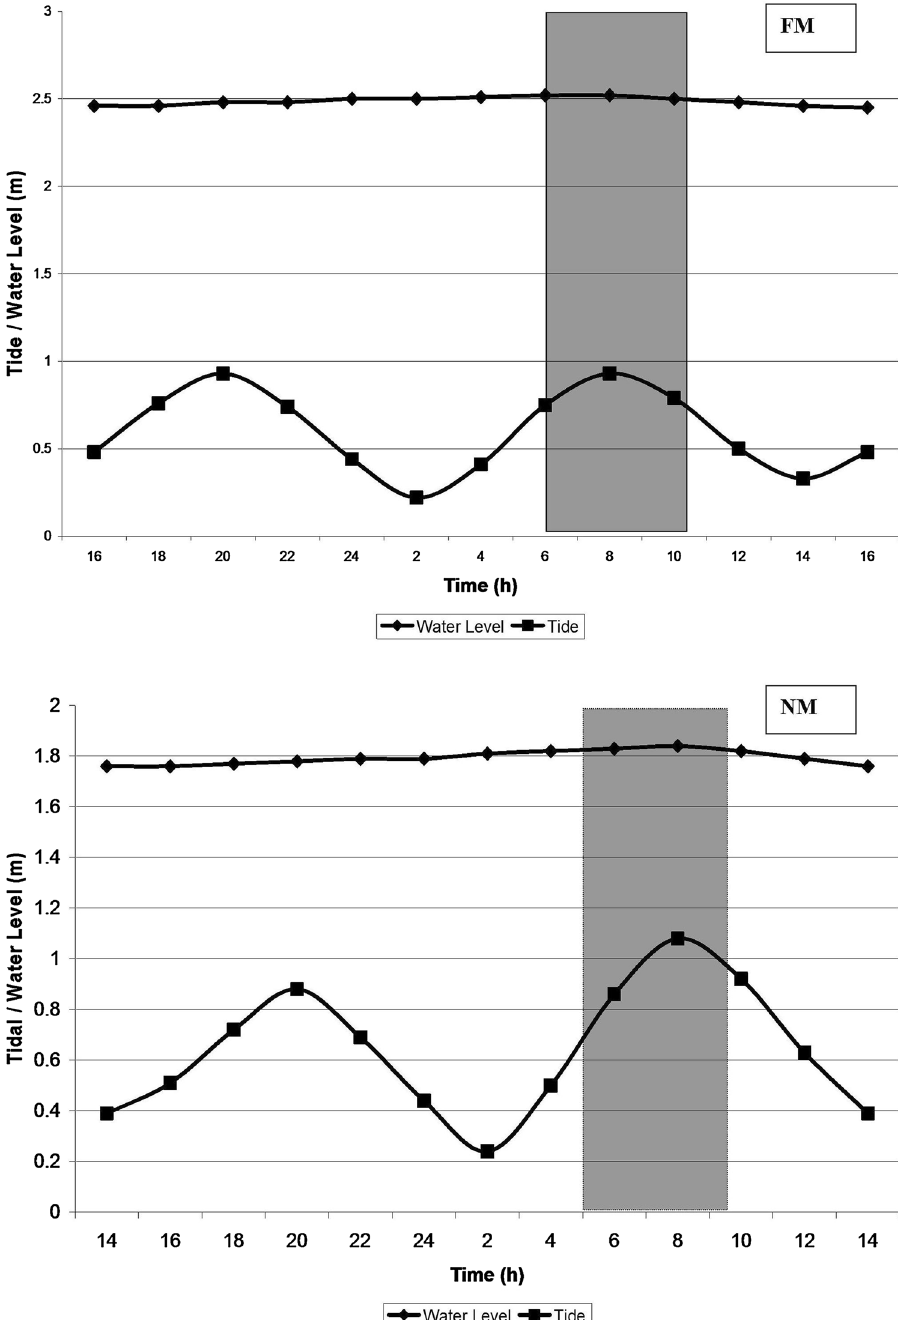
increase corresponds to the increase of tidal height around 8.00 am. Similarly the variation of water level in Rajapet- tai is 0.06 m during FM and 0.08 during NM (Fig. 5). At Tiyagavalli the variation of water level is 0.07 m at FM and 0.09 m at NM. Comparing FM and NM in all the three stations the water level variations is about 0.02 m; further the greater variation in water level is noted in new moon period in all the stations and the highest in Tiyagavalli Fig. 5 Water level and Tidal Influence during FM and NM at Rajapettai